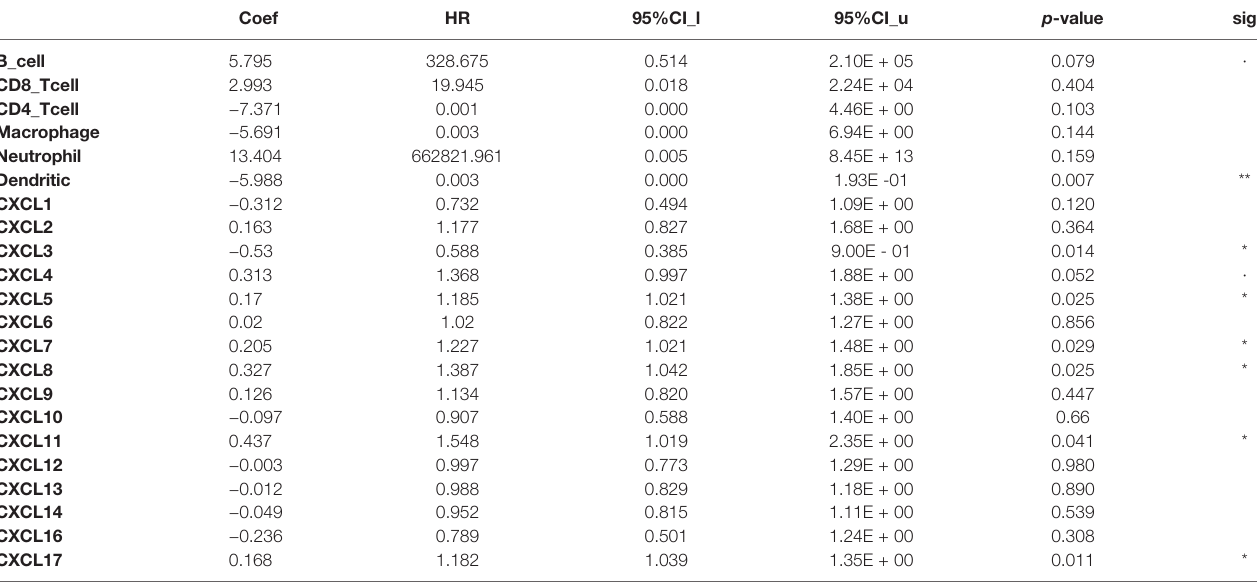
TABLE 3 | The Cox proportional hazard model of CXC chemokines and six tumor-in fi ltrating immune cells in PAAD (TIMER).